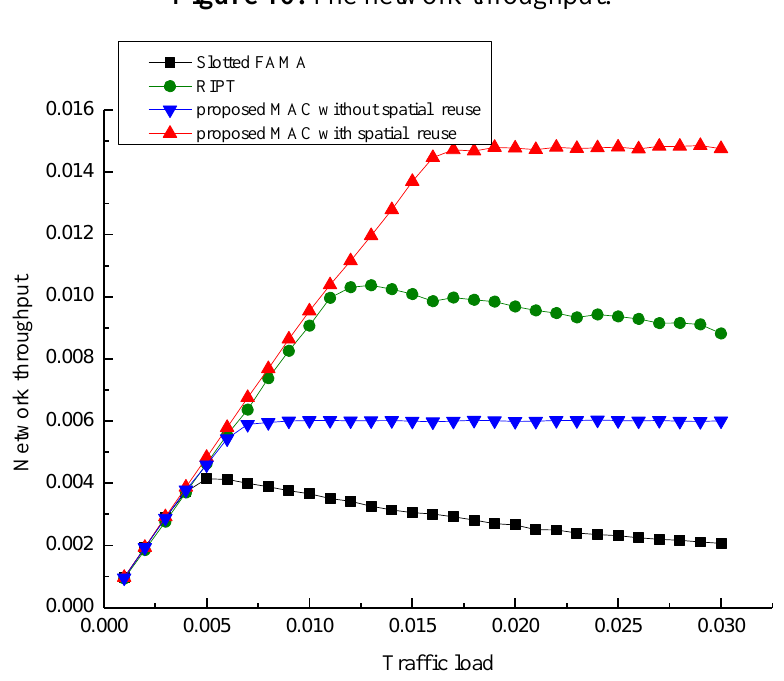
Figure 10. The network throughput.